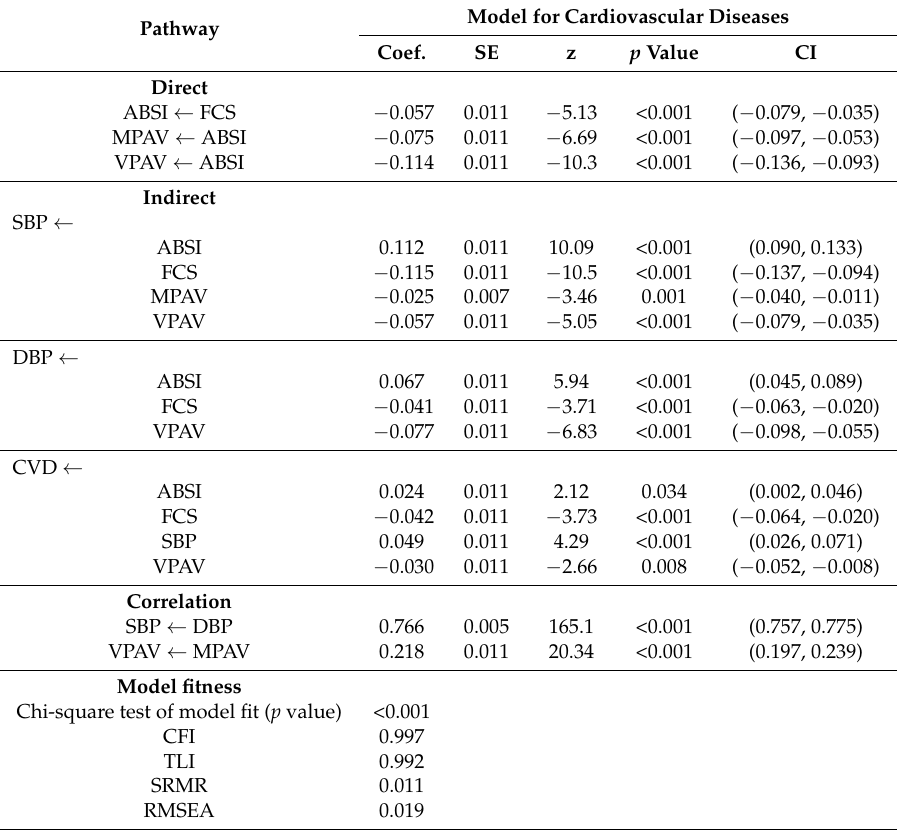
Table 4. Standardised path coefficients for pathways from food consumption score, body shape index, physical activity, blood pressures, and cardiovascular diseases in final model of SEM. Model for Cardiovascular Diseases Pathway Coef. SE z p